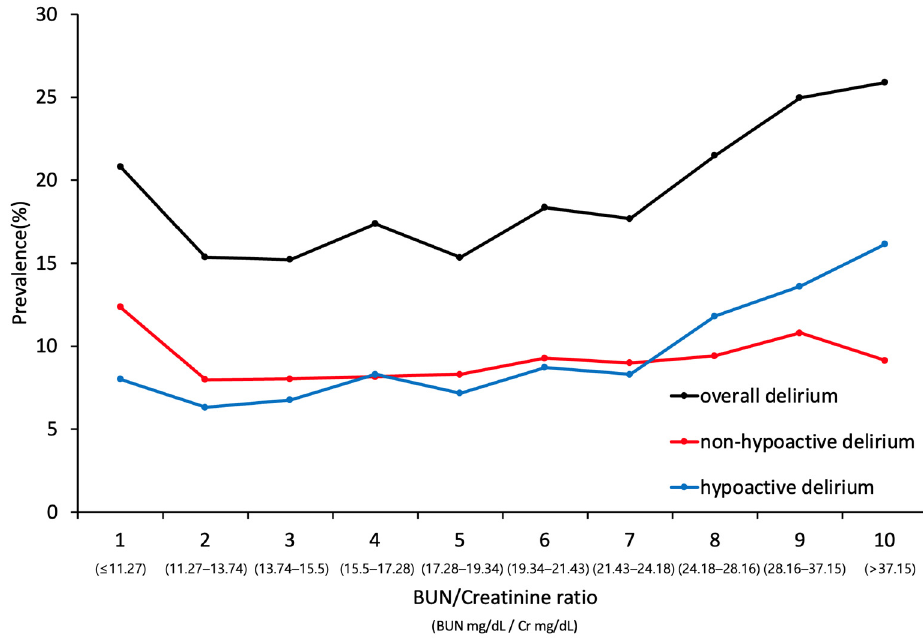
Figure 2. Association between prevalence of delirium subtypes and BUN/Cr ratio. Table 1. Baseline characteristics of patients.